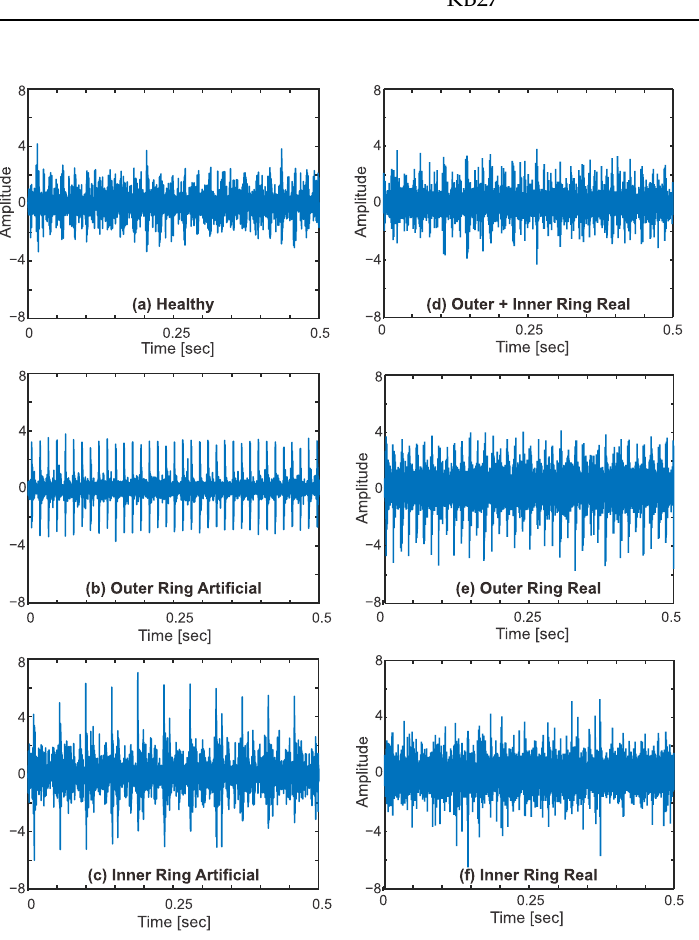
Figure 2. Time-domain raw vibration signal plots.